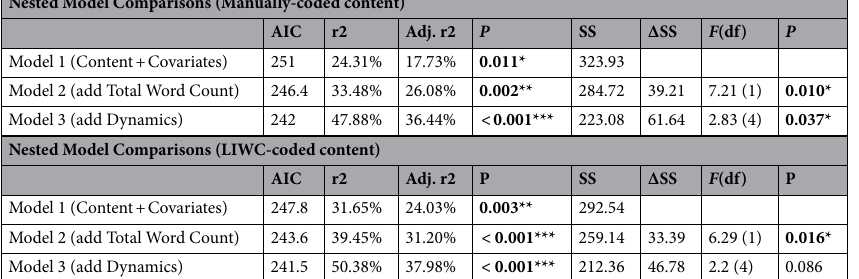
without the covariates (similarity with daily life, censorship, and similarity total word count) and the pattern of significant results was consistent. Thought content and dynamics account for unique variance in predicting trait brooding. In our nested model comparisons (Table 4), valence and % past-orientation were included as content predictors, and MNW positive , MNW negative , and affective transition probabilities Pos → Pos and Neg → Pos were included as dynamic indices. All models were significant (all p ’s < 0.02). Content, censorship and similarity to daily life (Model 1) collectively explained 17.73% of the variance in trait brooding, and the addition of total word count (Model 2) explained sig-